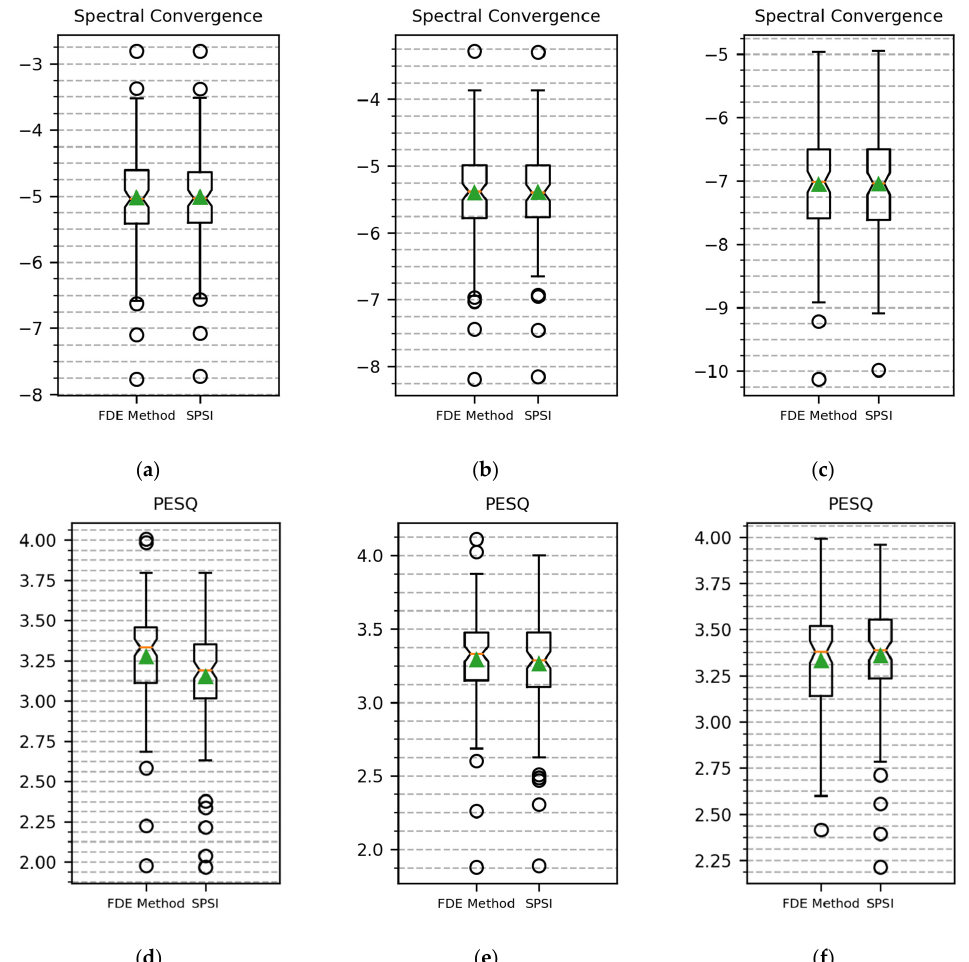
Figure 5. SC and PESQ boxplots for different hop sizes: ( a ) SC boxplot of FDE method and SPSI for hop size = 64, overlap = 87.5%; ( b ) SC boxplot of FDE method and SPSI for hop size = 128, overlap = 75%; ( c ) SC boxplot of FDE method and SPSI for hop size = 256, overlap = 50%; ( d ) PESQ boxplot of FDE method and SPSI for hop size = 64, overlap = 87.5%; ( e ) PESQ boxplot of FDE method and SPSI for hop size = 128, overlap = 75%; ( f ) PESQ boxplot of FDE method and SPSI for hop size = 256, overlap = 50%.